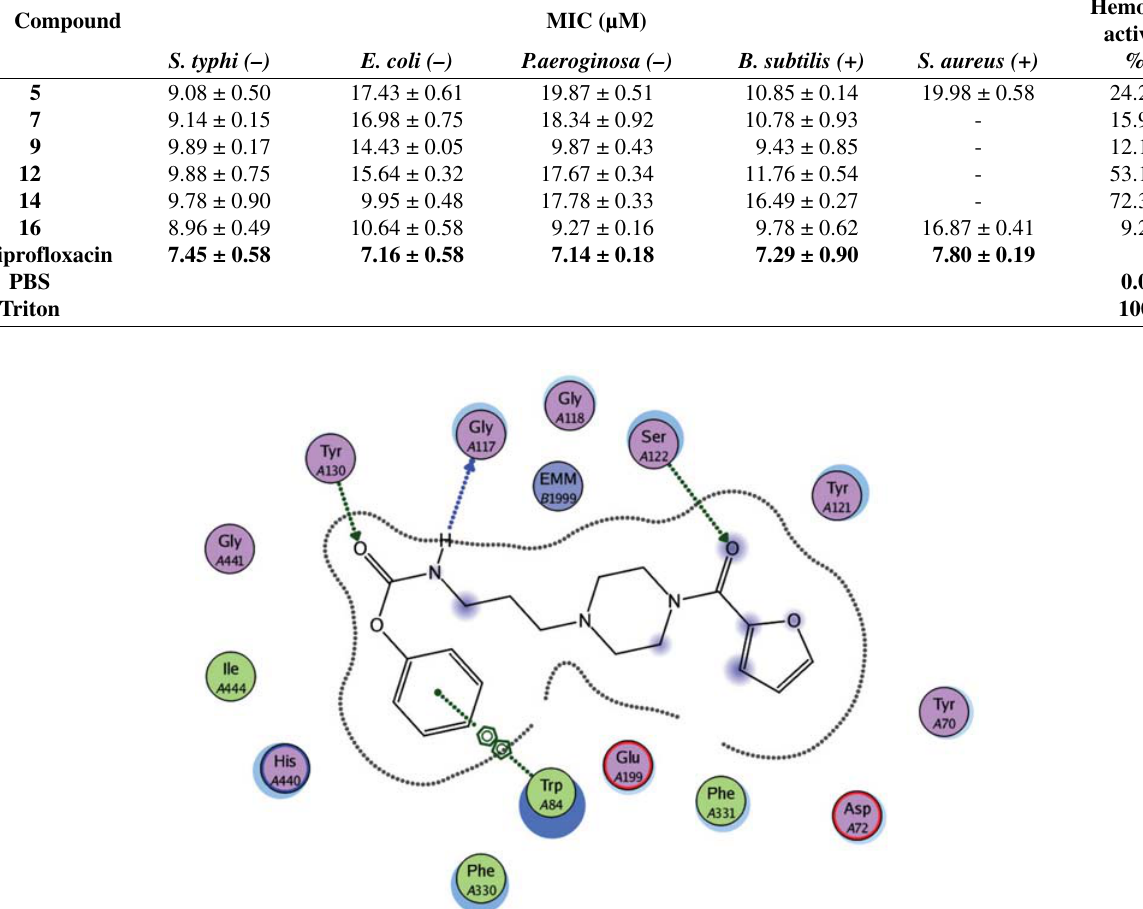
Table 2. Antibacterial activity (MIC) and hemolytic activity of different carbamate derivatives bearing 2-furoyl-1-piperazine